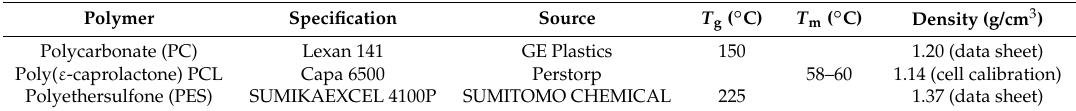
Table 1. Sources and characteristics of polymers studied in this